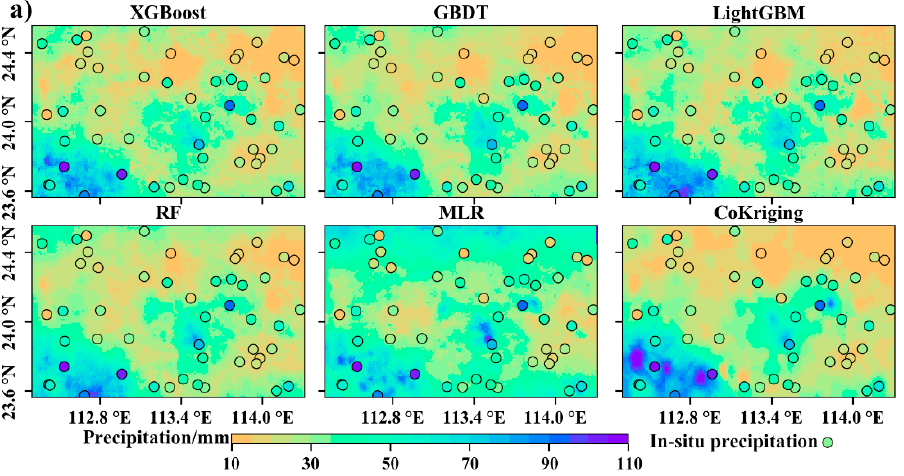
Figure 12. Distribution of the merging results based on the XGBoost, GBDT, LightGBM, RF, and MLR algorithms and the CoKriging interpolation results: ( a ) 18:00 on 23 April 2018, ( b ) 9:00 on 7 May 2018, ( c ) 7:00 on 30 August 2018, and ( d ) 13:00 on 16 September 2018.